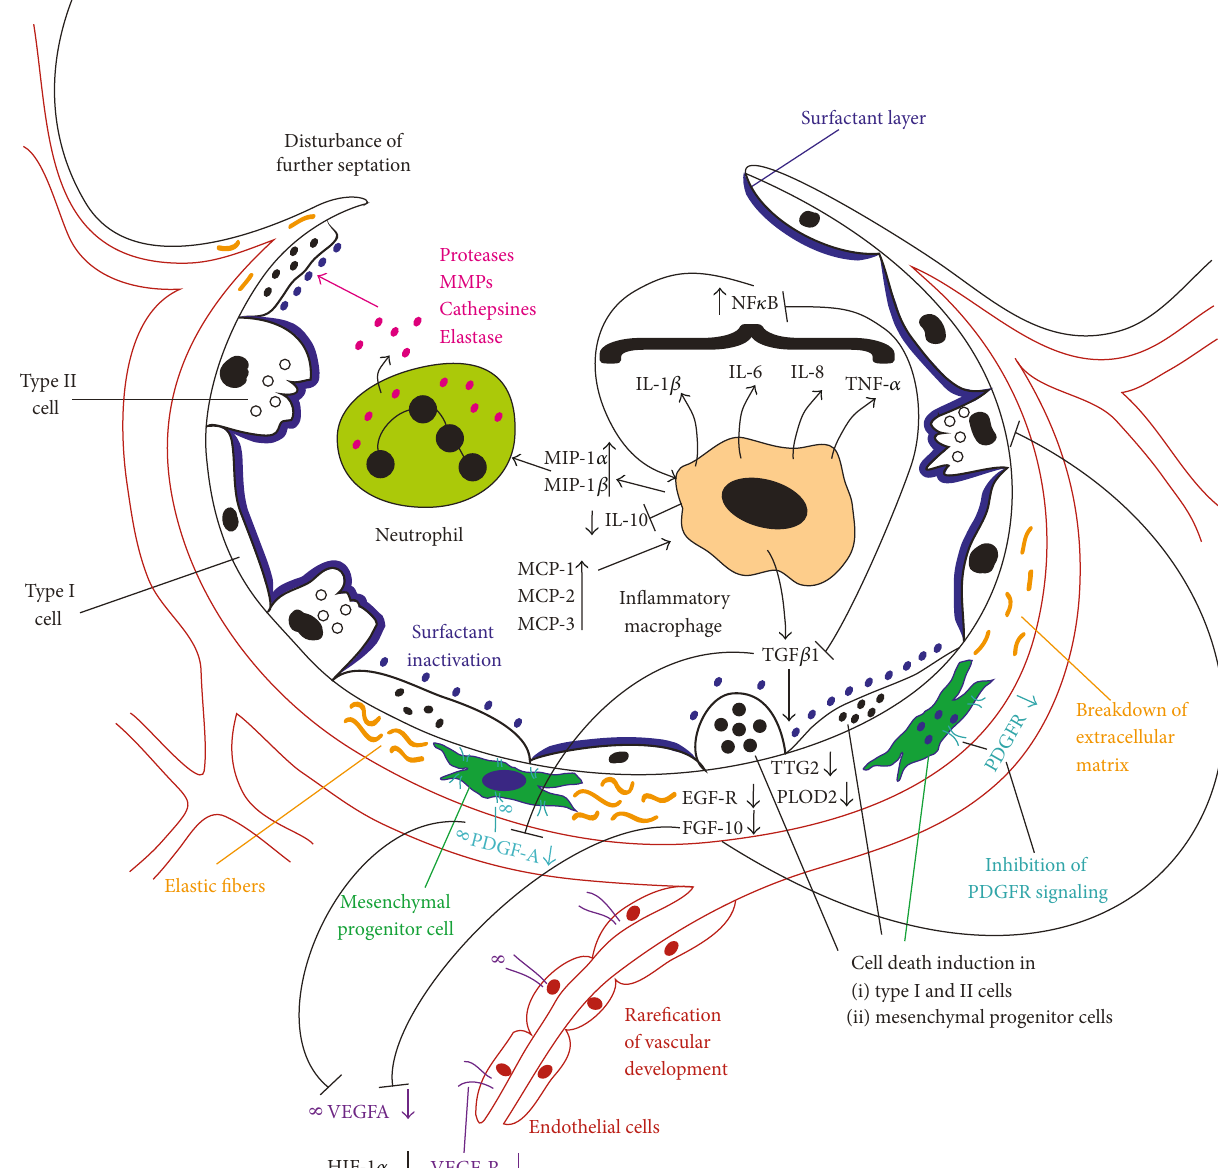
Figure 1: Pathogenesis of BPD: BPD is the consequence of distortion of alveolar, mesenchymal, and vascular development mainly in the saccular stage. Central to the disease is the in fl ammatory response which is characterized by a disbalance of cytokines and growth factors, the in fl ux of in fl ammatory cells, cell death induction, and surfactant inactivation. Distortion of mesenchymal progenitor cell function represents a key event in disease